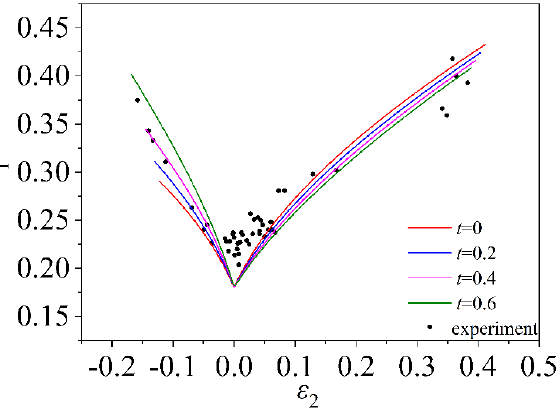
Figure 21. FLD of material TRIP780 based on Swift constitutive equation and MMFC instability criterion.